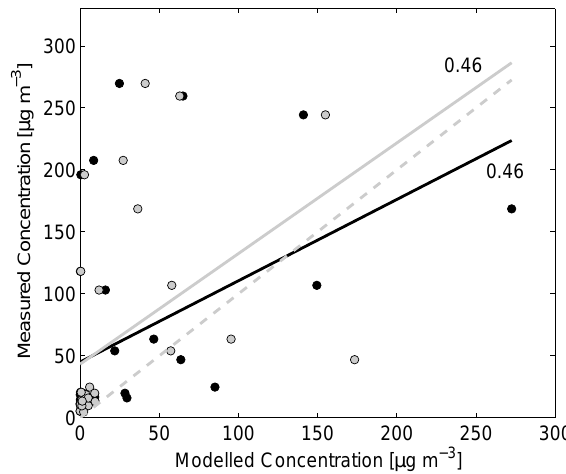
Fig. 12. Same as Fig. 11, but for model results based on GFS input